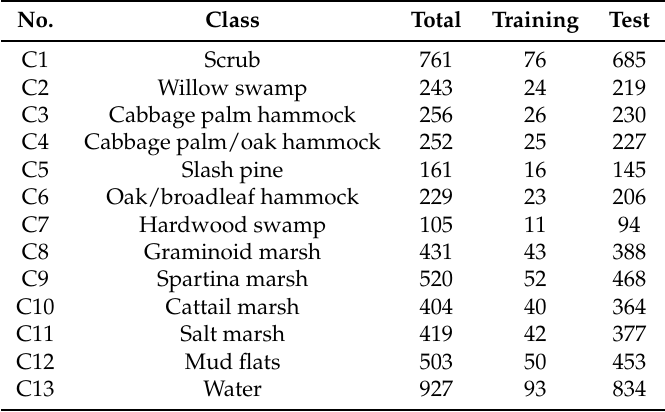
Table 3. Number of pixels for training/testing and the total number of pixels for each class in the KSC ground truth map.